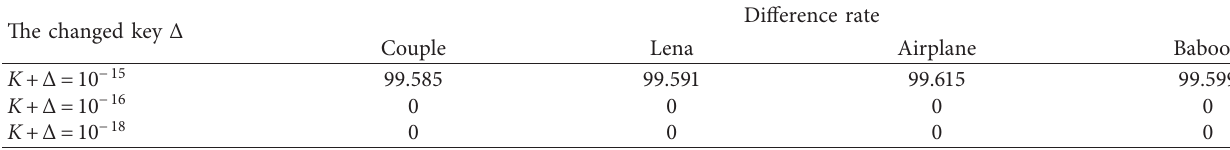
Table 3: The difference rate of slightly changing key with different images.